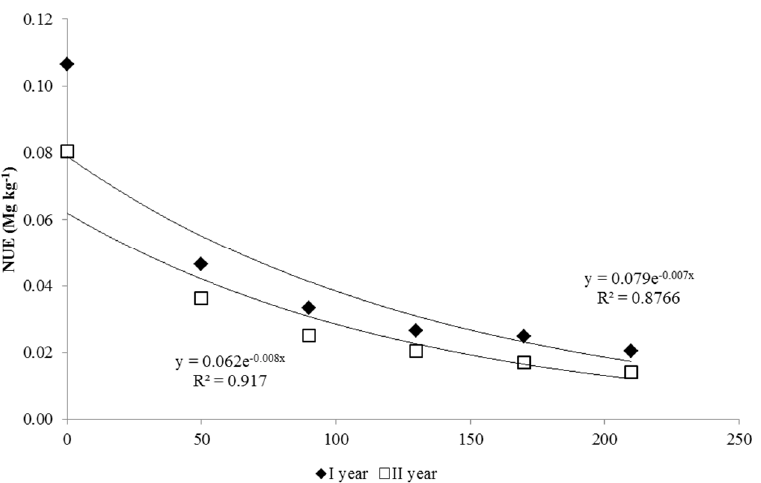
Figure 5. Exponential regression of NUE of tobacco crop vs. N fertilization rates in the two experimental years. For the explanation of the index, see Materials and Methods section.